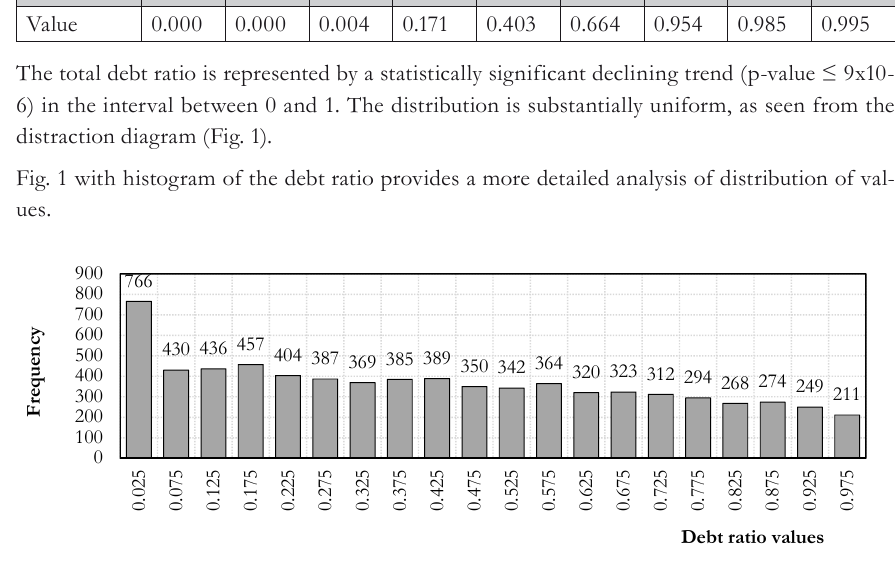
Fig. 1 – Histogram of the debt ratio. Source: Own